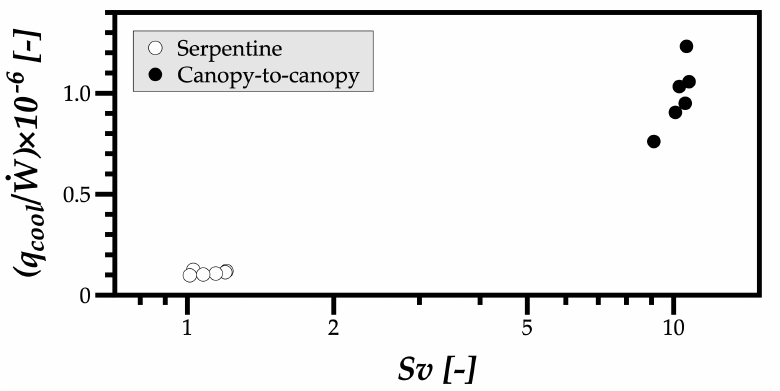
Figure 10. Relation between Svelteness for the serpentine configuration based on the length proposed for paths without ramifications and for the canopy-to-canopy configuration with the external length scale based on the proposal with